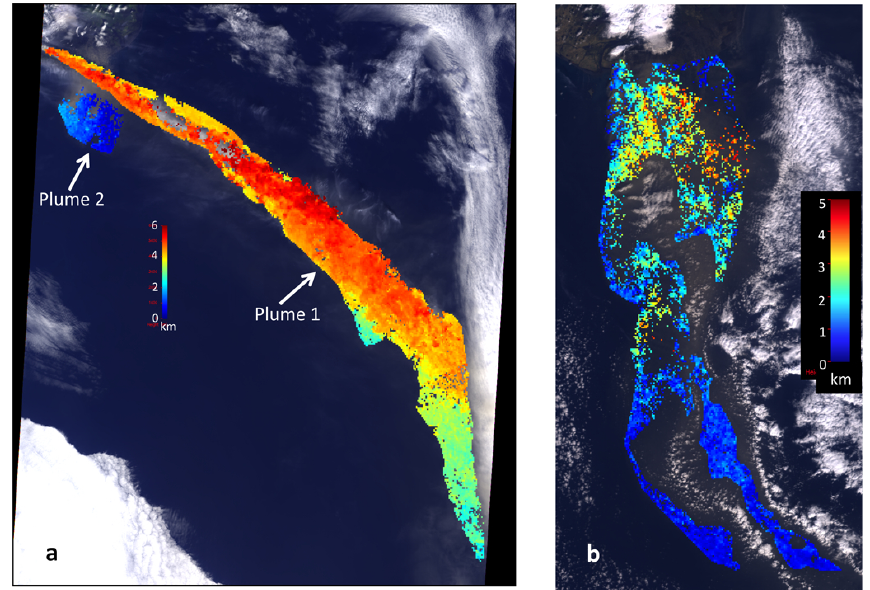
Fig. 2. MISR stereo height retrieval maps derived using the MISR INteractive eXplorer (MINX, Nelson et al., 2008; http://misr.jpl.nasa.gov/ getData/accessData/MisrMinxPlumes). (a) 7 May 2010 plume; Plume 1 is the main plume and Plume 2 is a secondary plume of remobilized ash. (b) 19 April 2010 plume. All heights are above sea level (a.s.l.), and are reported at 1.1km horizontal resolution. A wind correction has been applied, and the vertical accuracy of the resulting height retrievals is approximately